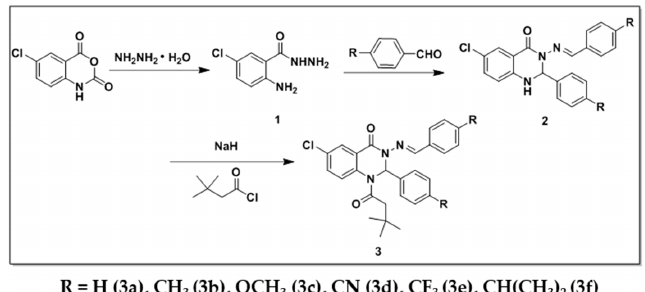
Figure 1. Synthetic route for 6-chloro-1-(3,3-dimethyl-butanoyl)-2-(un)substituted phenyl-2,3-dihydroquinazolin-4(1 H )-one (PDQL).